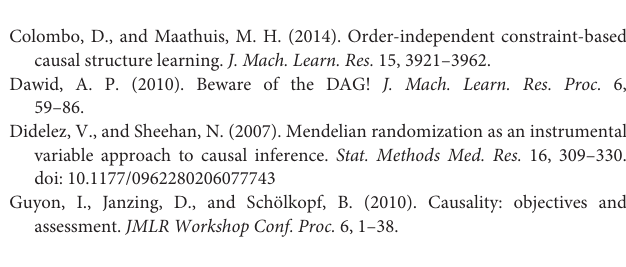
Supplementary Figure 1 | A sample analysis pipeline using the R package MRPC for simulating and analyzing data. Supplementary Figure 2 | A sample analysis pipeline using the R package MRPC for analyzing real data. Supplementary Data | R code for data